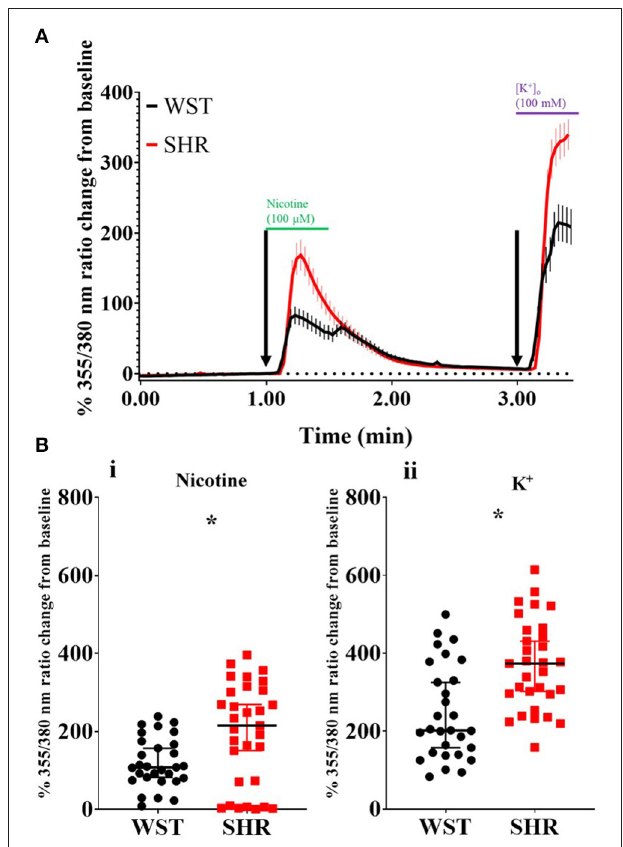
FIGURE 1 | Wistar ( n = 29 neurons, 5 cultures, 2–4 rats per culture) and SHR ( n = 31 neurons, 6 cultures, 2–4 rats per culture) stellate neuron Ca 2 + transients in response to pharmacological stimulation. (A) Mean trace (with SEM) of stellate neuron [Ca 2 + ] i during the experimental protocol involving exposure to 100 µ M nicotine, followed by 100 mM K + . (B) Peak stellate neuron [Ca 2 + ] i transient in response to nicotine (i) and K + (ii). Peak response data are presented as median with IQR; * signifies p < 0.05 for Wistar vs. SHR, Mann-Whitney test.